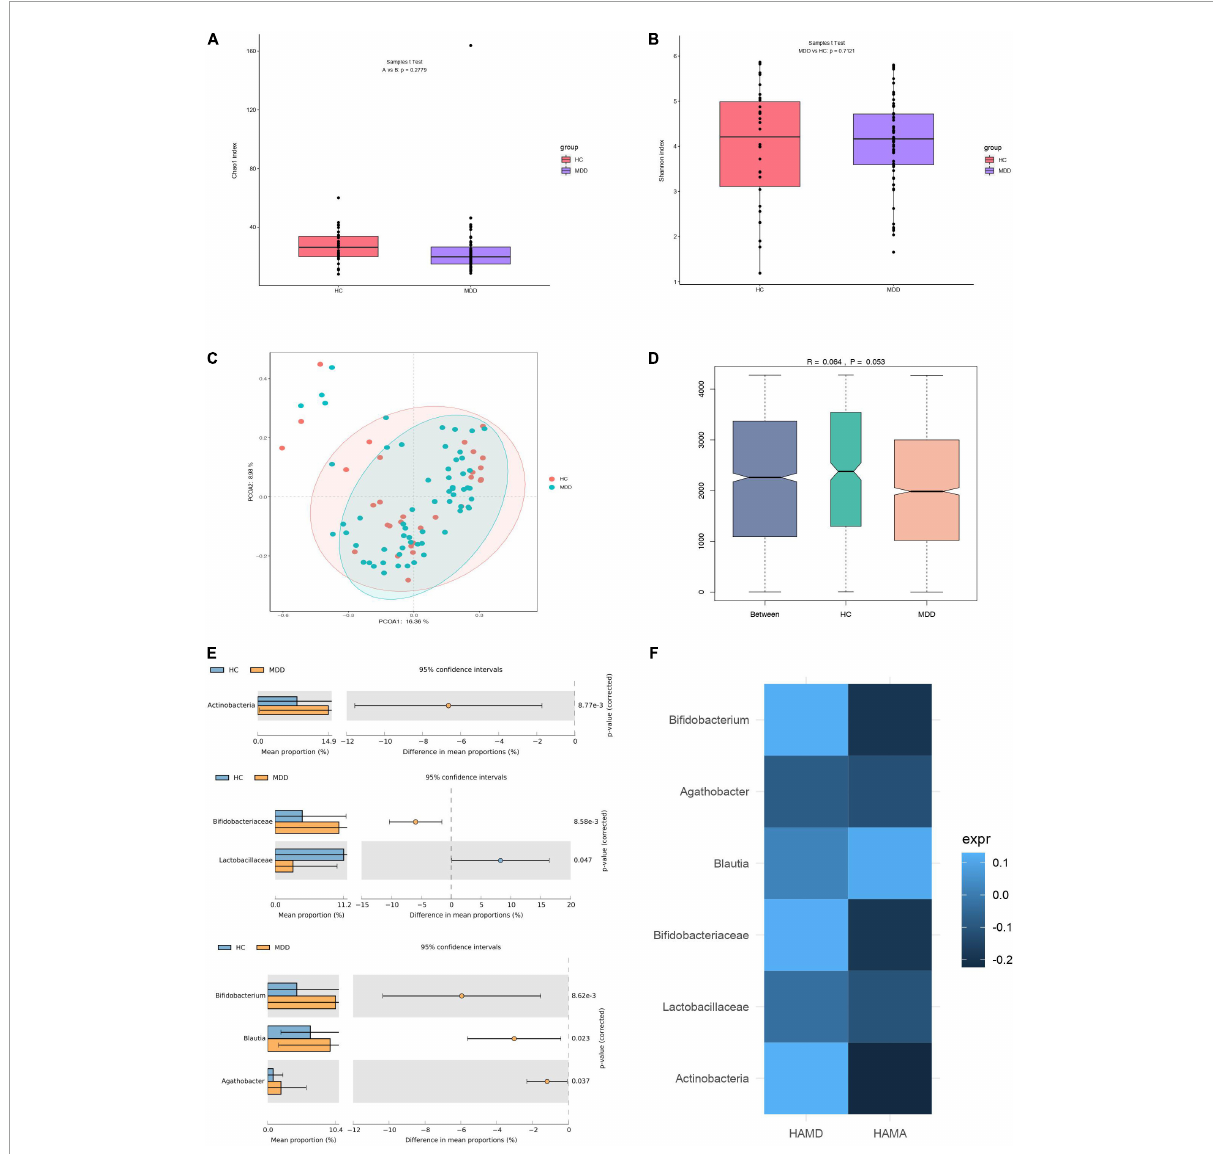
FIGURE1 Differences in gut microbiota between MDD patients and HCs. (A) Bacterial richness estimated using the Chao1 index. (B) Bacterial diversity estimated using the Shannon index. (C,D) β -diversity of gut microbiota according to principal coordinate analysis (PCoA) and analysis of similarities (ANOSIM) based on Bray–Curtis distances. (E) Significantly different species according to FDR-adjusted p -values, calculated using Welch’s t -test. The mean abundance of the blue (yellow) community differed between MDD patients and HCs. (F) Heatmap of correlations between significantly different species and clinical indicators, determined using the Spearman